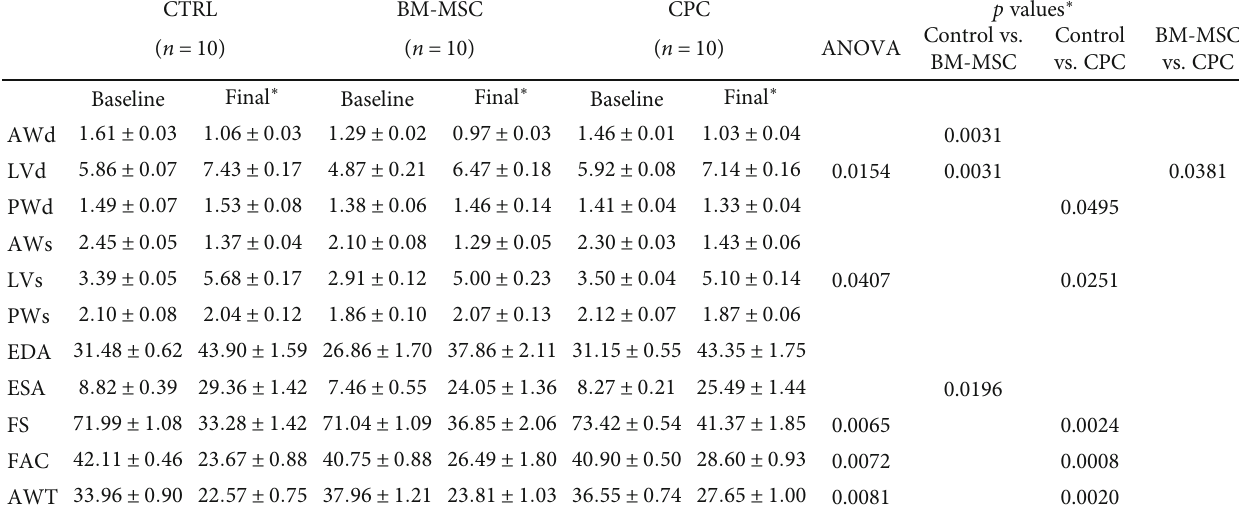
Table 1: Echocardiographic values of the control, BM-MSC, and CPC groups at baseline and 4 weeks after myocardial infarction. CTRL BM-MSC CPC p values ∗